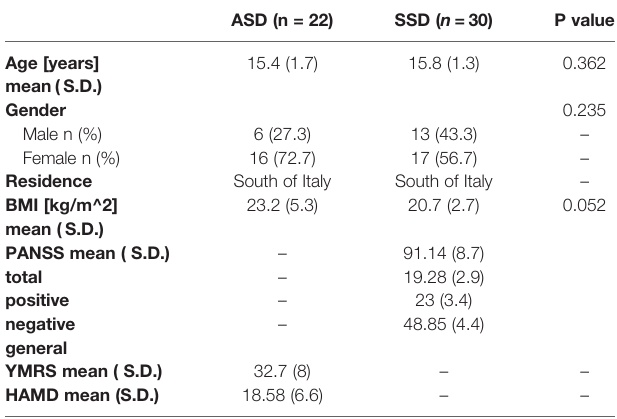
TABLE 1 | Demographic and clinical features of ASD and SSD patients.